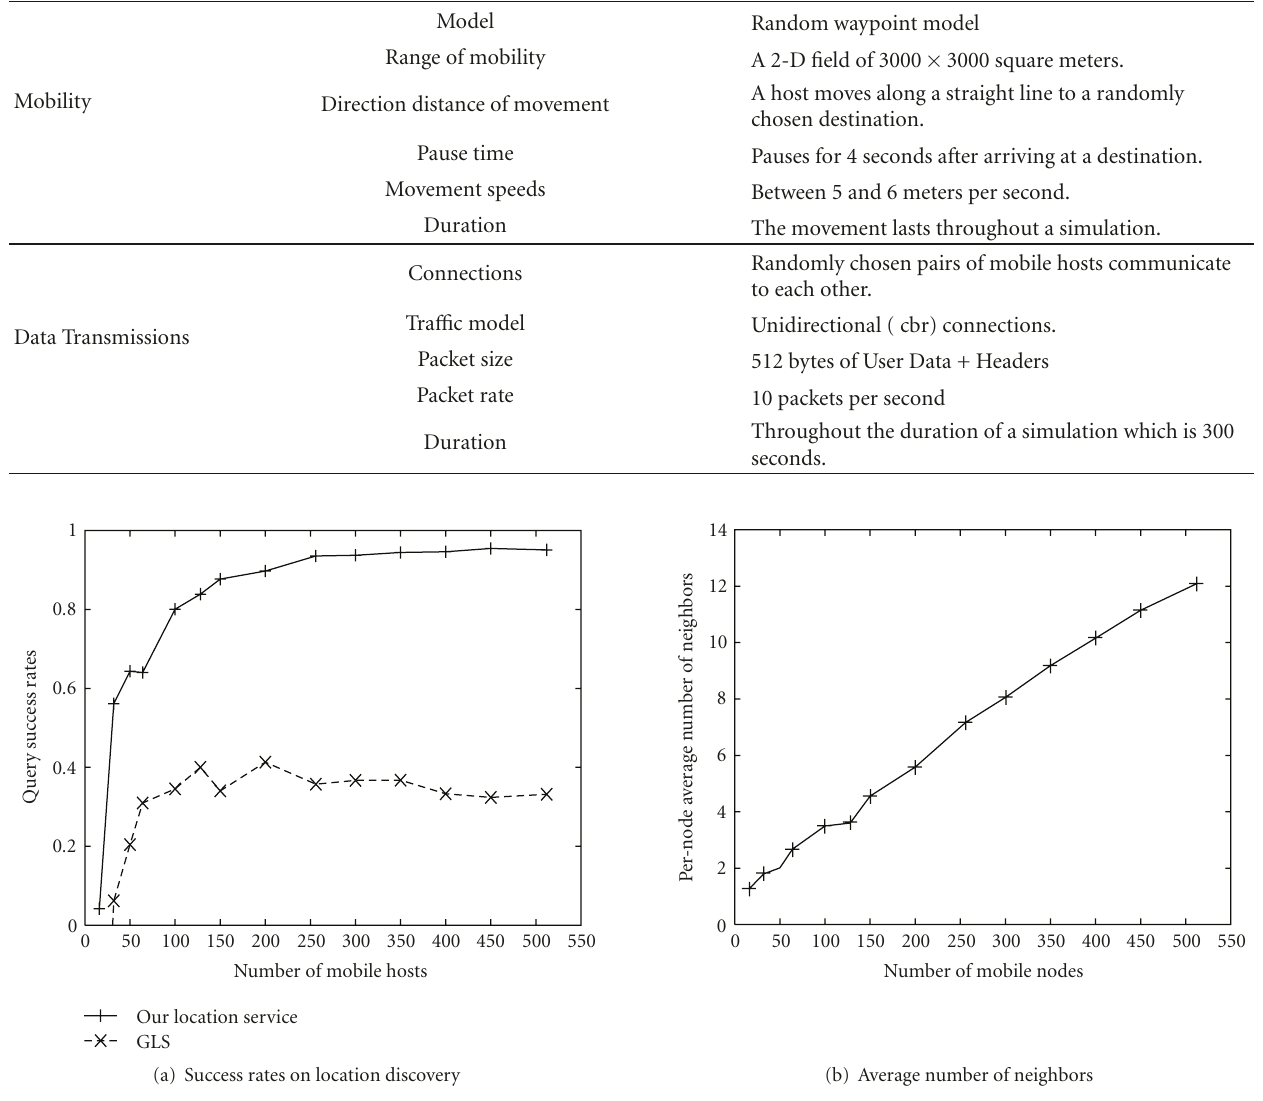
Figure 3: The performance of the PTLS service. Simulations are run in a 3000 × 3000 meter 2